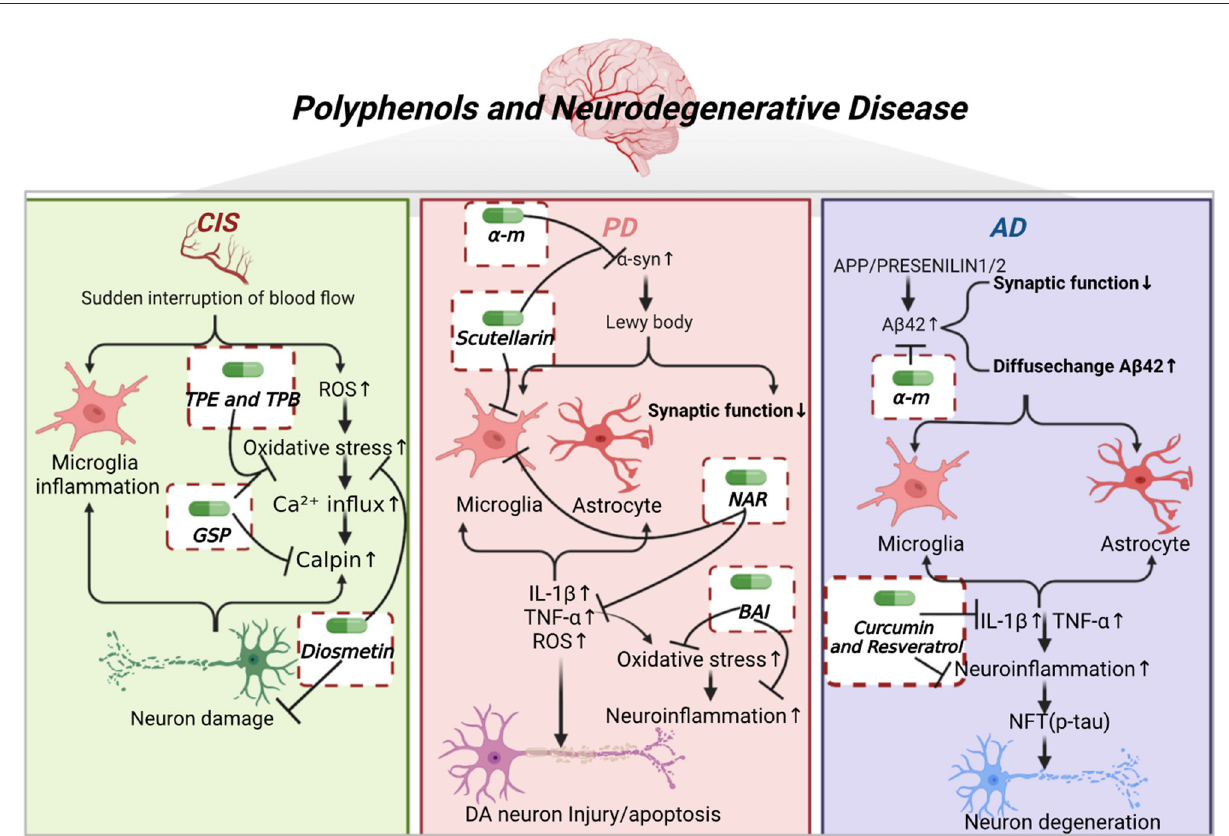
FIGURE1 Polyphenols and neurodegenerative diseases. CIS is caused by the sudden interruption of blood flow to the brain, leading to brain cell death and nerve damage. Subsequently, it causes microglia activation, elevates ROS, inward calcium flow, and calmodulin release, leading to neuronal death. TPE, TPB, GSP, and diosmetin inhibited oxidative stress. GSP also inhibited calpain activation, and diosmetin exerted neuroprotective effects. PD is caused by the aggregation of α -syn proteins into Lewy bodies, leading to decreased synaptic function, and further activation of microglia and astrocytes. This leads to the release of inflammatory factors such as IL- β , TNF- α , and ROS, causing elevated levels of oxidative stress, neuroinflammation and damage or apoptosis of DA neurons. α -M and scutellarin inhibited the aggregation of α -syn oligomers. Scutellarin and NAR inhibited the activation of microglia. NAR inhibited the release of inflammatory factors. BAI inhibited the oxidative stress and neuroinflammation. AD is caused by the deposition of A β 42 aggregates, which activates microglia and astrocytes to release inflammatory factors and leads to neuroinflammation as well as NFT. α -M inhibited the aggregation of A β 42 oligomers. Curcumin and resveratrol inhibited the release of inflammatory factors and neuroinflammation, thereby attenuating neuronal